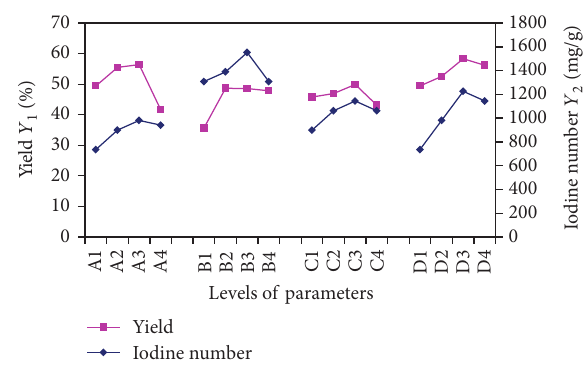
F 1: e effect of operational parameters on responses of